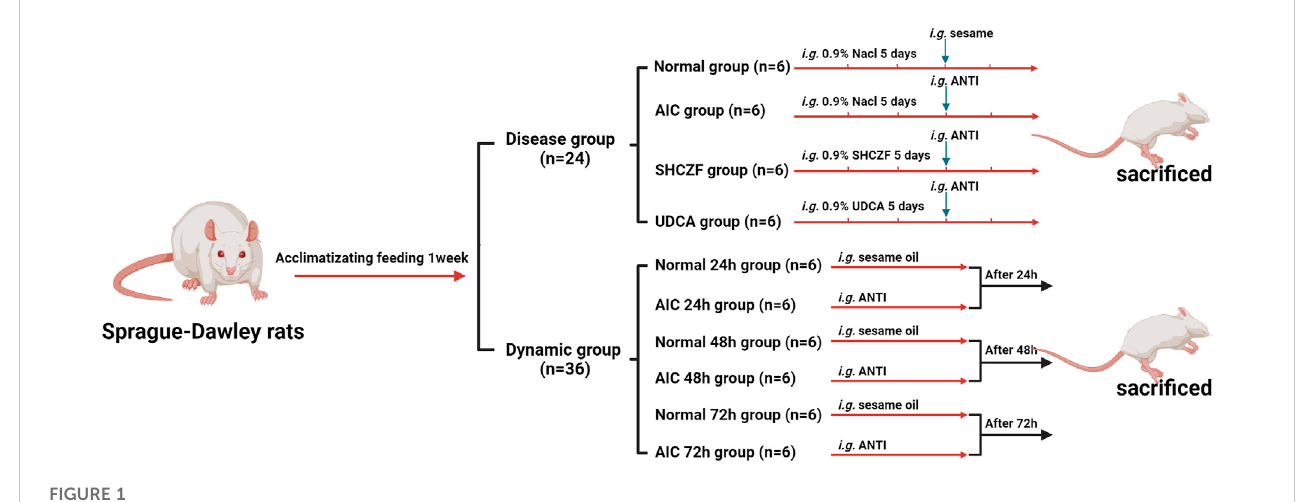
FIGURE 1 The fl ow of animal grouping and